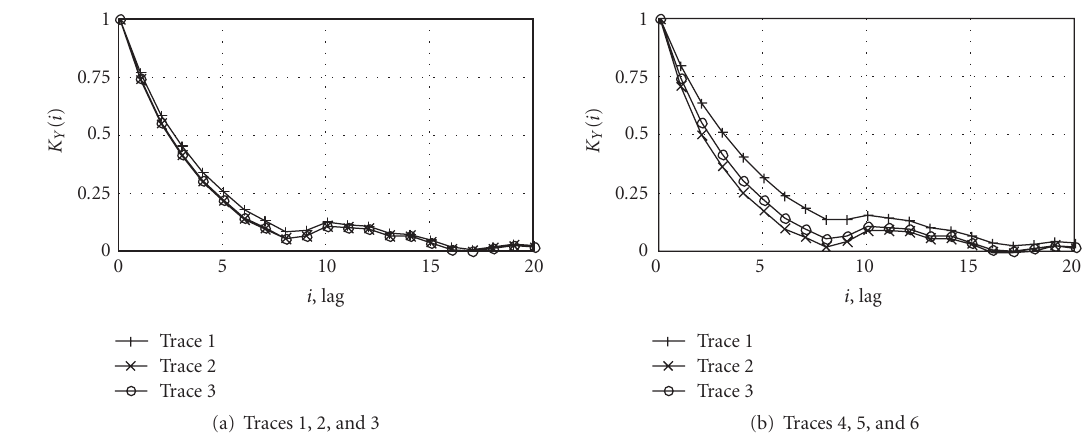
Figure 7: Normalized autocorrelation functions of